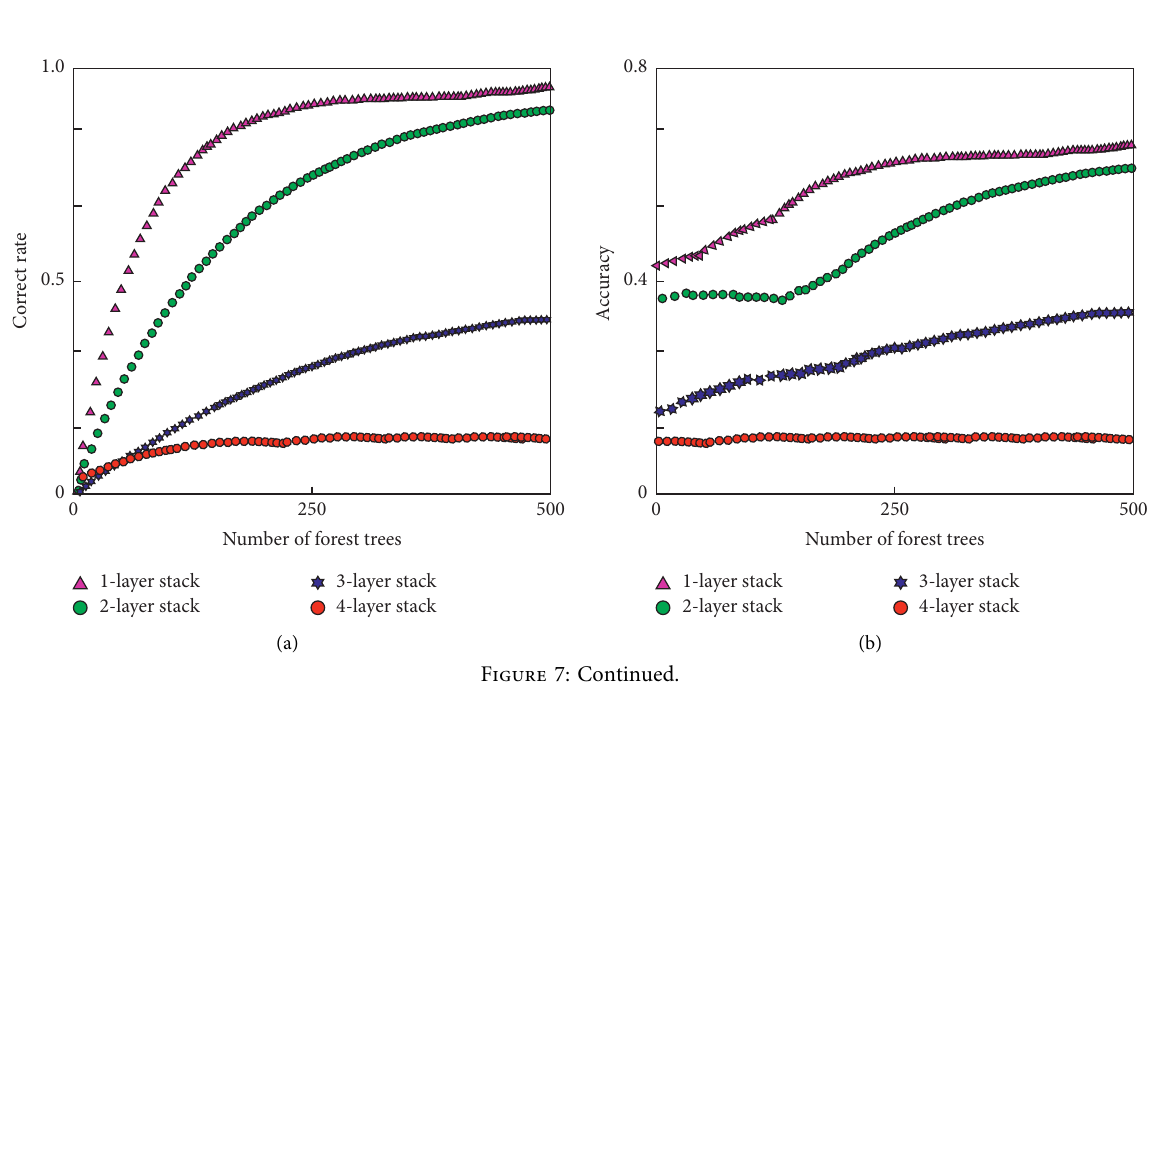
Figure 6: Effect of different cost functions on prediction model performance: (a) accuracy prediction comparison; (b) comparison of accuracy prediction; (c) recall prediction comparison; (d) forecast F1-measure comparison; (e) AUC value prediction comparison; (f). comparison of runtime